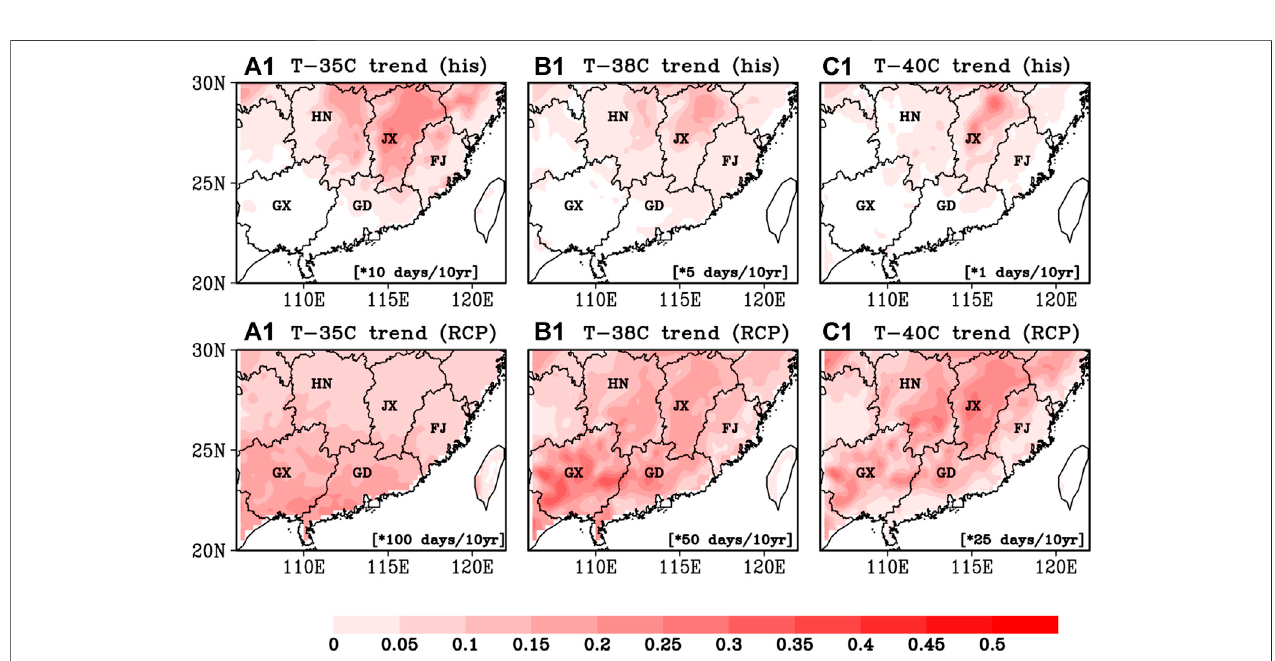
FIGURE 5 | Local linear trends of MME mean EHTDs at three T-levels during historical period of 1980 – 1999, and RCP8.5 period of 2080 – 2099. To gain better visibility, the patterns in the fi gures are the results of dividing a factor shown on the bottom into the real variable data.